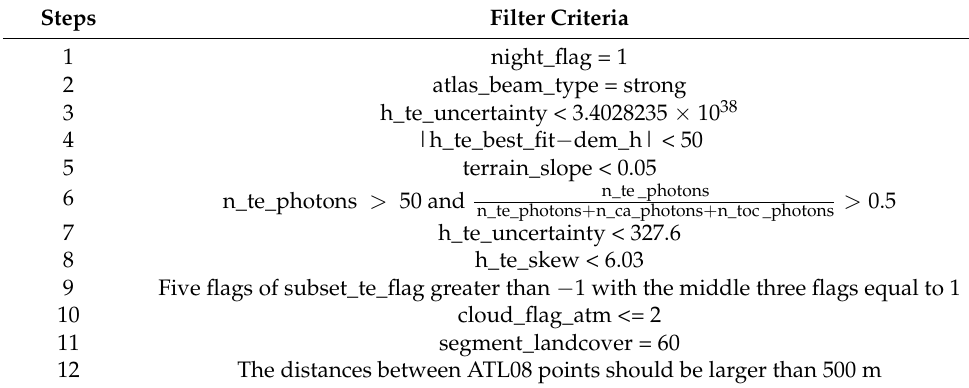
Table 3. The criteria for extracting GCPs from the ATL08 data.